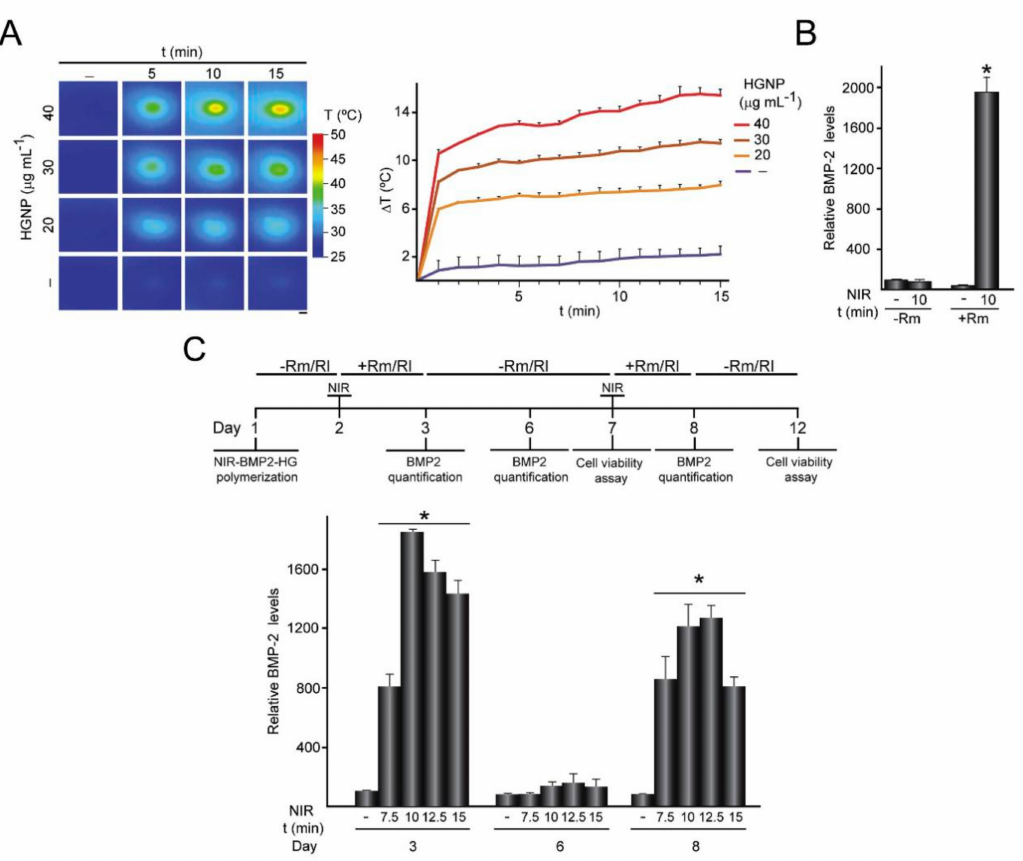
Figure 5. Activation of NIR-BMP-2-HG triggered by NIR light. ( A ) NIR-BMP-2-HG, polymerized with the indicated concentration of HGNP, were cultured for 1 day and then irradiated with NIR laser for the indicated times. ( B ) BMP- 2 concentration in media conditioned by NIR-BMP-2-HG polymerized with 30 µ g · mL − 1 HGNP. ( C ) NIR-BMP-2-HG, polymerized with 30 µ g · mL − 1 HGNP, were NIR-irradiated in the presence of 10 nM Rm or 100 nM rapalog AP21967 (Rl). Timeline scheme of NIR-BMP-2-HG preparation, NIR irradiation of hydrogel (NIR), * p < 0.05, culture in the absence (-Rm/Rl) or presence (+Rm/Rl) of rapamycin or rapalog and analytical assays [127]. Copyright 2020,